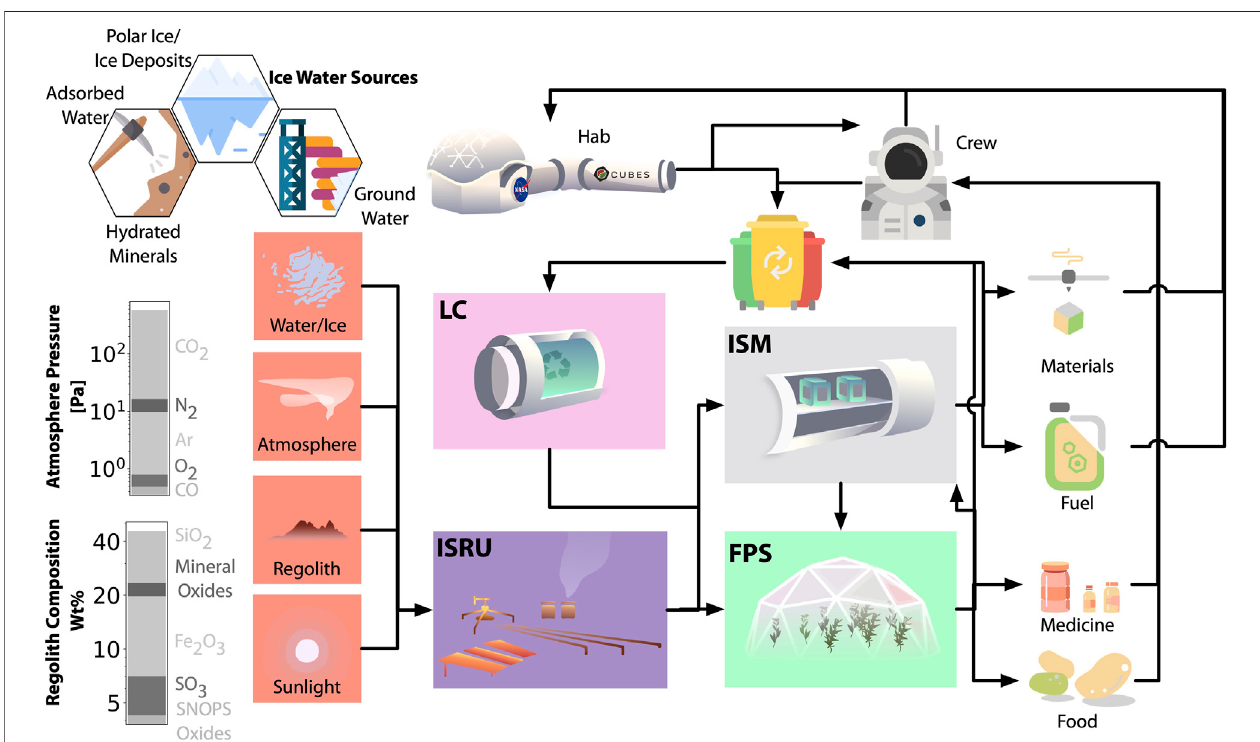
FIGURE 2 | Proposed surface operations are drawn from inventories of in situ resources (red) such as ice, atmosphere, regolith, and sunlight. Atmospheric feedstocks of carbon and nitrogen are biologically fi xed via the ISRU ( in situ resource utilization) biomanufactory components (including abiotic processes, purple), providing the source of biopolymer manufacturing via the ISM ( in situ manufacturing) component (grey) and food via the FPS (food and pharmaceutical synthesis) component (green), which are used for astronaut consumption and utilization during mission operations. Waste from each of these elements is collected and fed into the LC (loop closure) element (pink) to maximize ef fi ciency and reduce the cost of supply logistics from